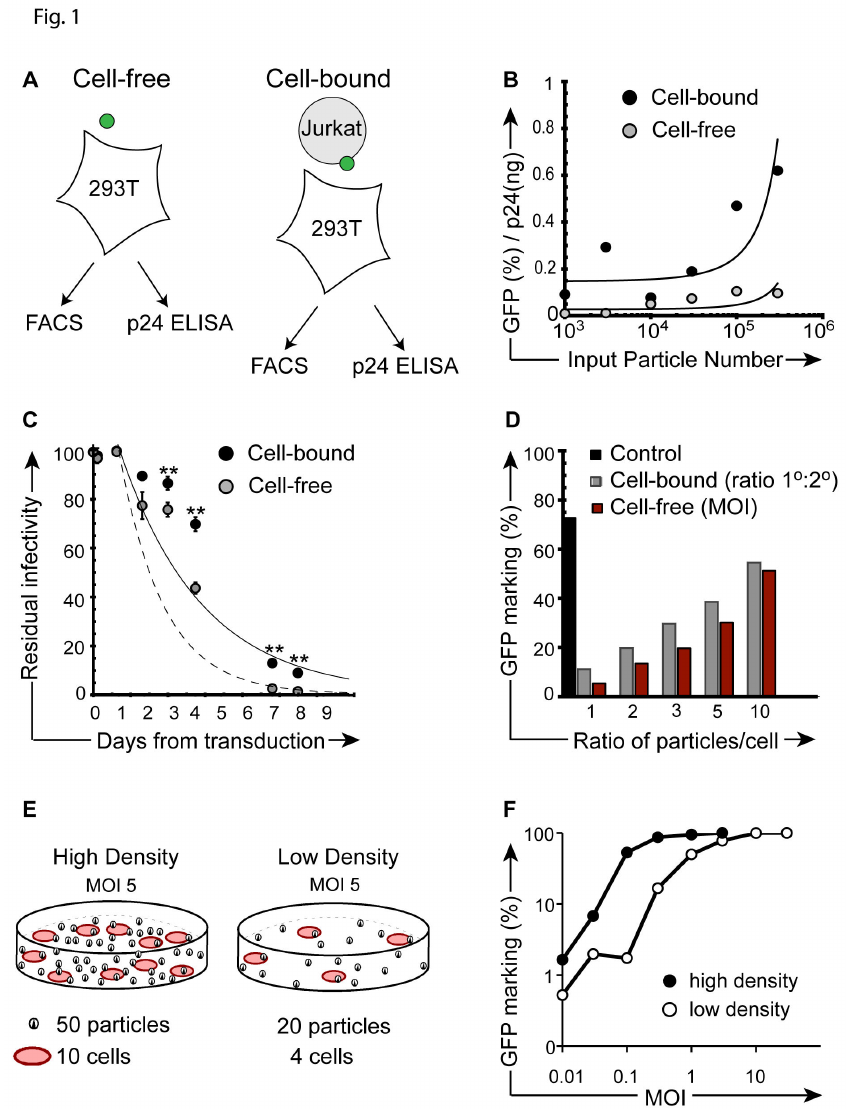
Figure 1. Enhanced gene transfer after direct cell-cell contact of 1 o and 2 o targets. ( A ) Experimental design, illustrating cell- free (left) and cell-bound (right) transduction strategies. ( B ) Ratio of relative infectivity (% GFP / ng p24) after 24-hour direct cell-free transduction versus transduction by (Jurkat) cell-bound particles following co-culture. The y -axis ratio reflects GFP marking (FACS) per ng input vector (p24 ELISA) at increasing vector particle numbers ( x -axis), corresponding to MOI 0.01-3. Refer to Methods section for detailed procedure. ( C ) Residual infectivity of cell surface bound versus cell-free particles. Particles were kept at 37 o C and identical aliquots (MOI 1, based on vector titer) were removed at indicated time points for transduction culture of 1 x10 5 293T cells (cell free, black circles). For the cell-bound conditions, the same number of vector particles were arrested on the surface of 1 o target Jurkat cells (MOI 1) at 4 o C, before shift to 37 o C. Aliquots of 1 x10 5 cells were subsequently placed in coculture with 293T 2 o targets at the indicated time-points. A 2-tailed paired Student’s t test was performed; p values ≤ 0.01 are indicated by double asterisks. ( D ) Relative GFP marking in secondary 293T cells after direct co-culture (24 hours) by escalating the number of GFP vector exposed Jurkat cells (1 o , CD45 + ) to 293T (2 o , CD45 - ) cells at stable MOI of 1 ( ratio , gray bars), or by escalating MOI during exposure of primary cells, with matched 1:1 cell numbers ( MOI , red bars). Direct transduction of 293T cells with cell-free vector (black bar, control). ( E ) Illustration of experimental design used in (F). ( F ) Transduction of Jurkat cells under high cell density transduction (1x10 6 cells per ml, black circles) or low cell density (1x10 5 cells per ml, open circles) transduction conditions over a range of MOI. Cells were transduced in the presence of 4 µg/ml protamine sulfate. Following a 3-hour transduction at 37°C, cells were washed, placed back in culture at 37°C, and flow cytometry was performed 72 hours later. All experiments were repeated with similar results. doi: 10.1371/journal.pone.0074925.g001 PLOS ONE |